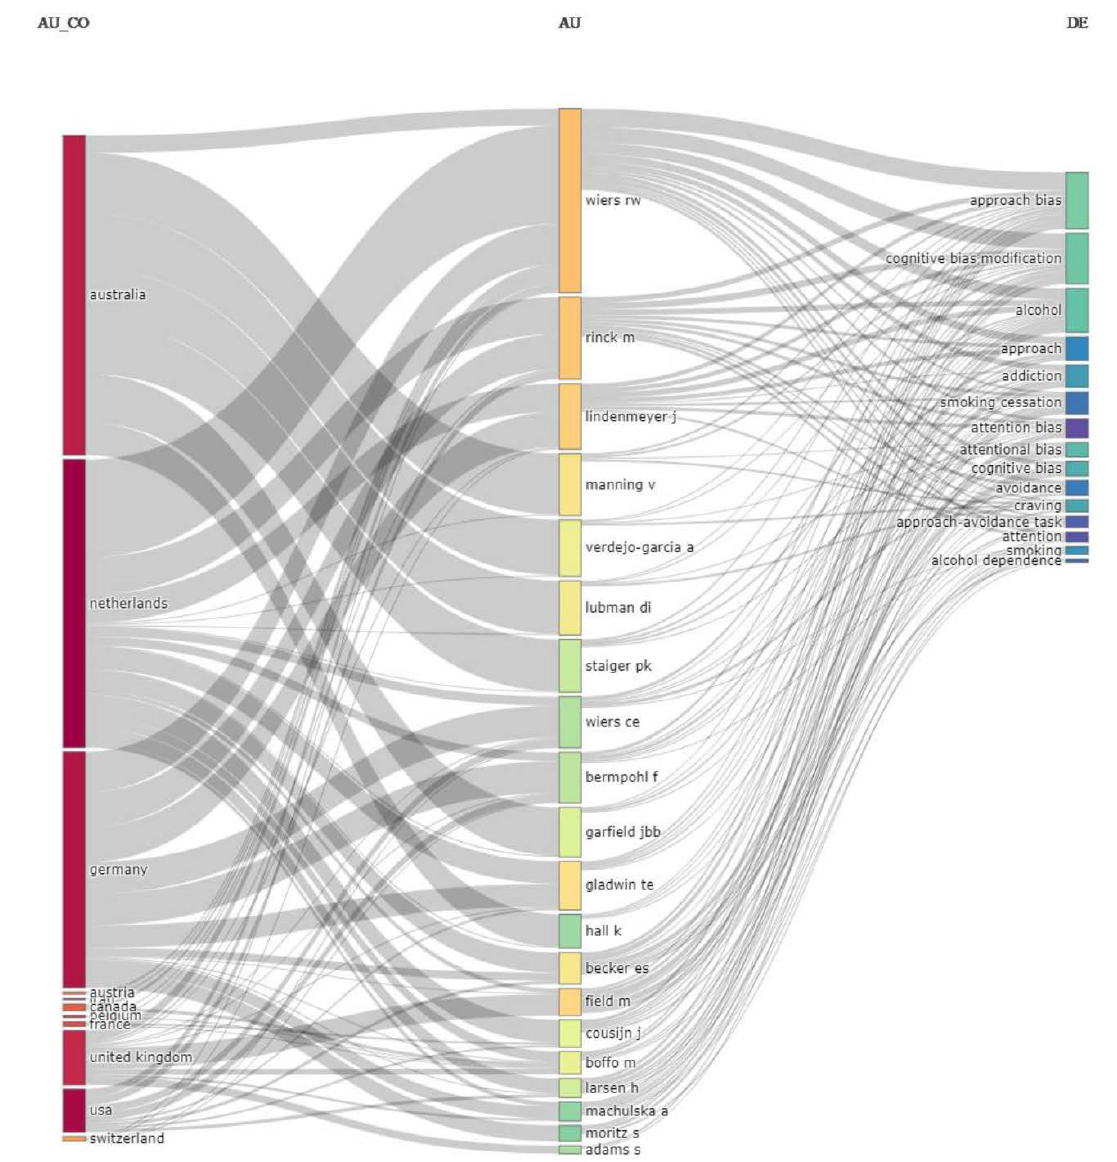
Figure 3. Three-field plot showing the association among countries, authors and keywords used.